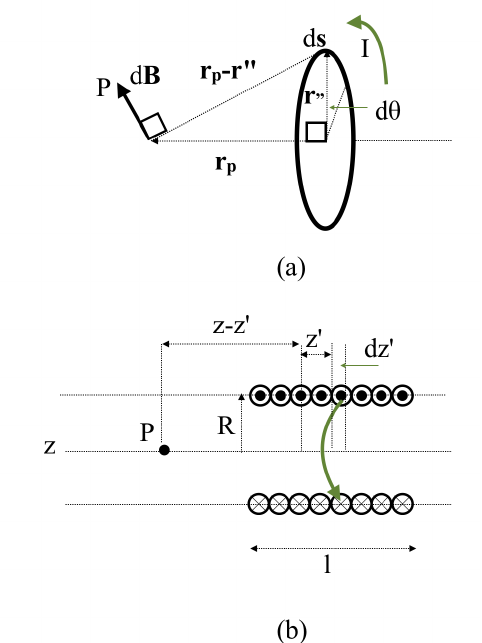
Figure 2. ( a ) Magnetic field at an arbitrary point P resulted by a circular current carrying element and ( b ) magnetic field at an arbitrary point generated by a current carrying